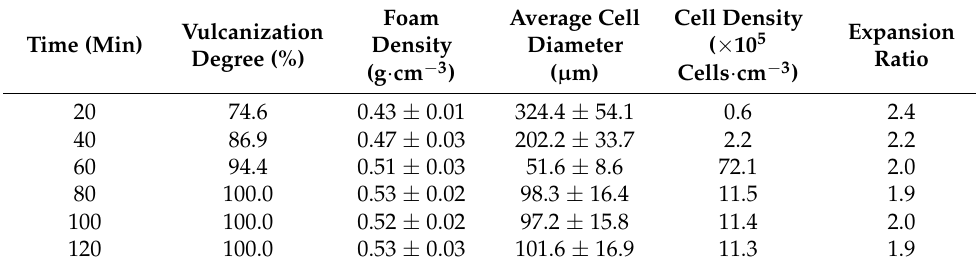
Table 6. Parameters of foamed samples with different foaming